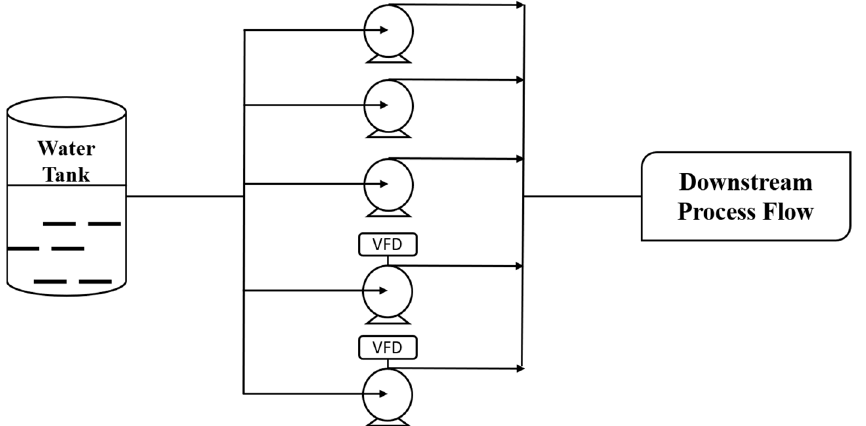
Figure 1. Diagram of parallel operation of variable-frequency pumps.